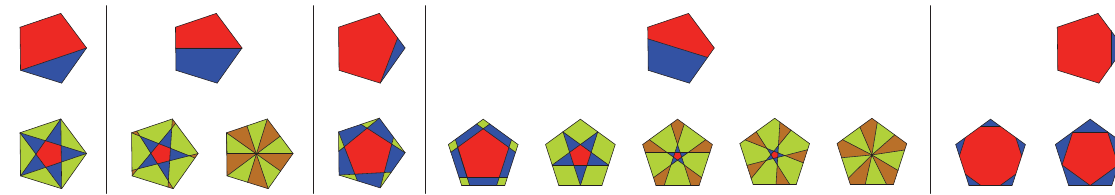
Figure 41. VV and VS cuts of square and hexagon.